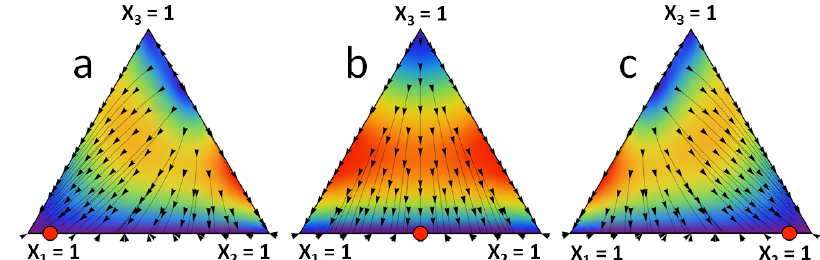
Figure 2. The red circle shows the unique stationary state of the RMD for matrix A , with mutation fractions m = m = m , and mutation rate µ = 10 − 4 , for three different combinations 1 2 3 of values of the payoffs [ α , β , γ ]. ( a ) [ α , β , γ ] = [0.99, 0.01, 0.4]; ( b ) [ α , β , γ ] = [0.5, 0.5, 0.4]; ( c ) [ α , β , γ ] = [0.01, 0.99,